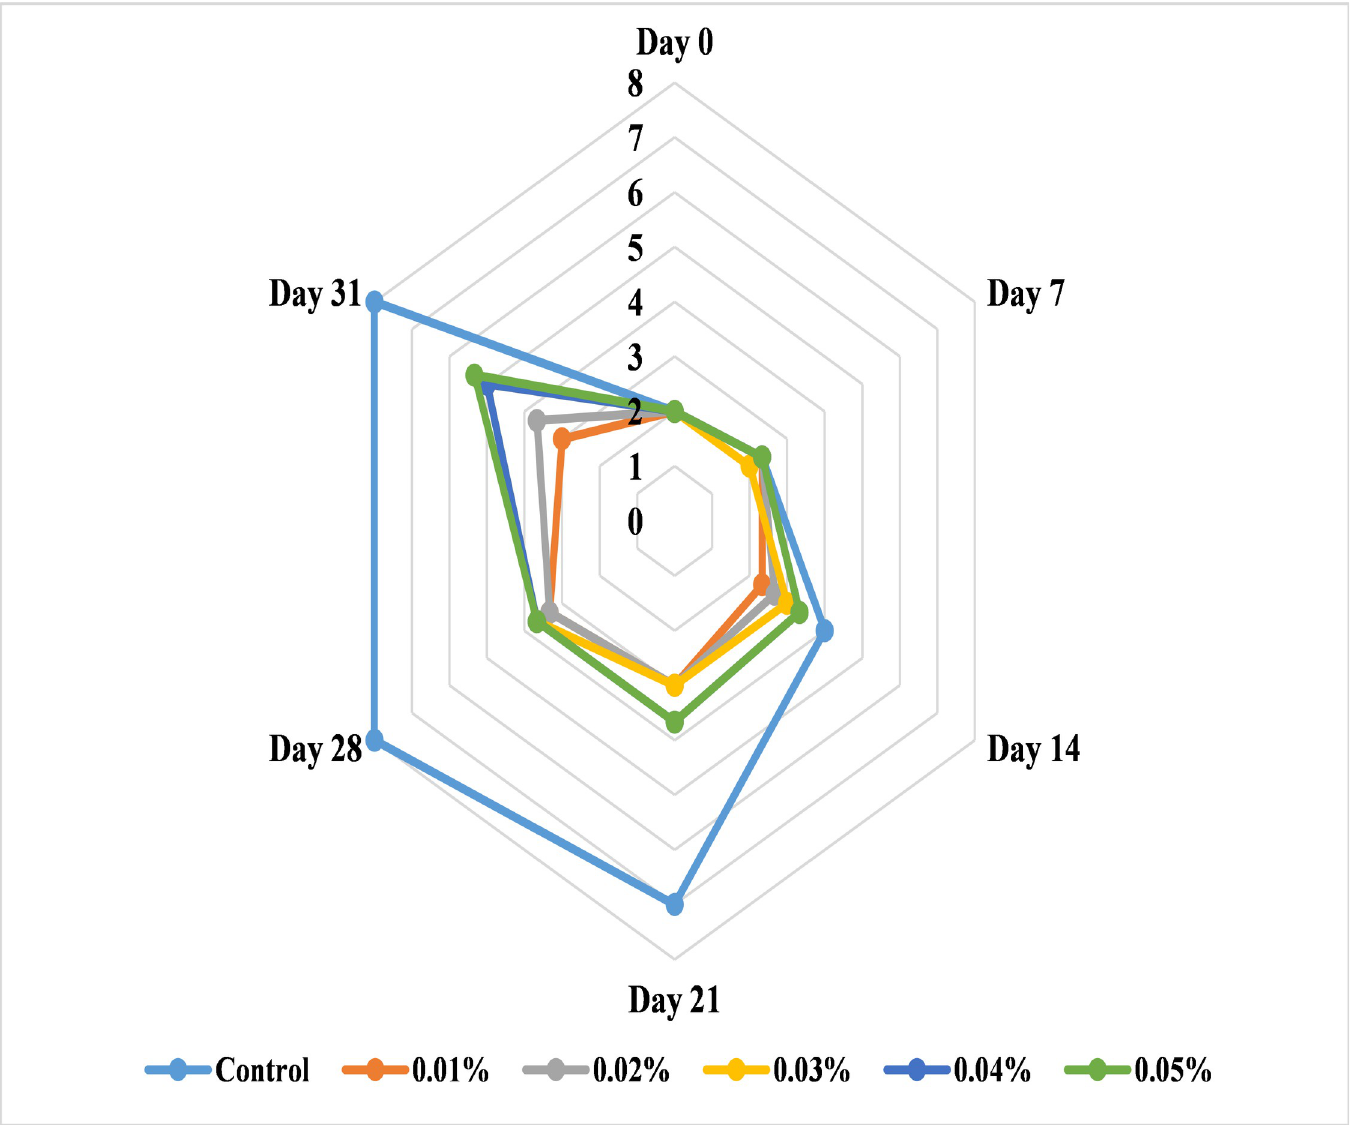
Fig 10. Effect of AgNPs concentrations (T0 = control, T1 = 0.01%, T2 = 0.02%, T3 = 0.03%, T4 = 0.04%, T5 = 0.05%) on color of Cavendish banana (BASRAI) during 32 days of storage.